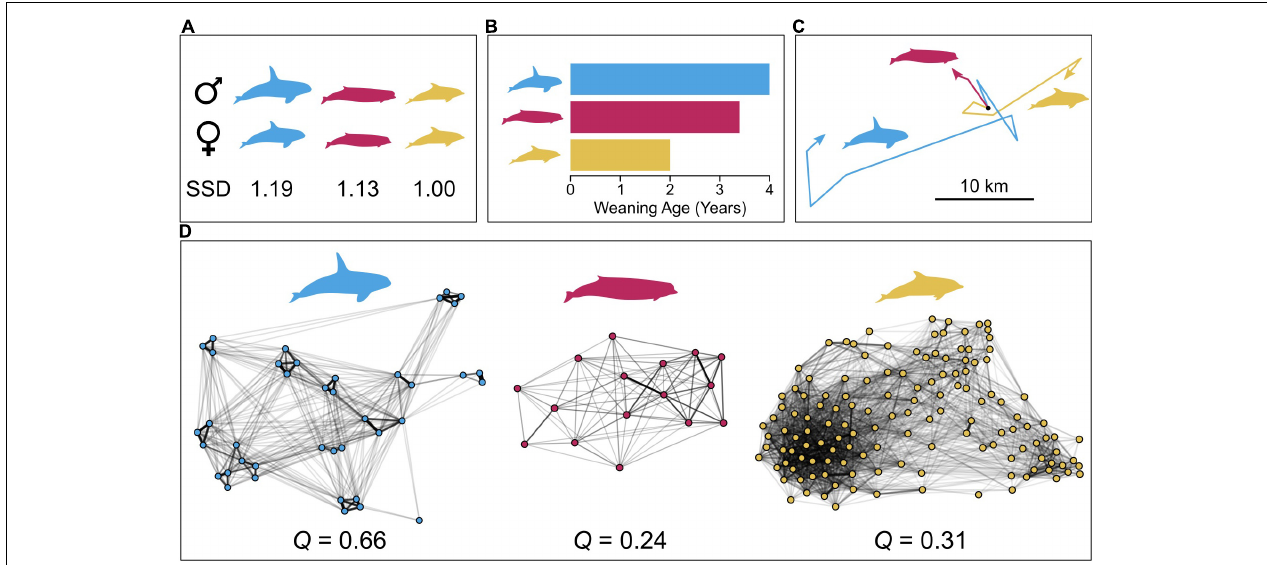
FIGURE 2 | Comparison of network structure and hypothesized drivers in three species of toothed whale, killer whales (blue), northern bottlenose whales (red), and common bottlenose dolphins (yellow). Top panels indicate sexual size dimorphism (SSD) (A) , maternal investment, approximated by weaning age (B) , and the distribution of resources, as approximated by movement patterns (C) . The bottom panel (D) contains plots of group-based half-weight index networks for each species with accompanying modularity estimate. Sexual size dimorphism estimates are the ratio of male to female lengths, and are taken from Dines et al. (2015). Weaning ages are based on stable isotope analysis of dental layers (killer whales: Newsome et al., 2009; bottlenose whales: Feyrer et al., 2020; bottlenose dolphins: Fruet et al., 2015). Movement data are tracks of single individuals obtained from animal-borne devices (radio tag for bottlenose whales, satellite tags for bottlenose dolphins and killer whales) over approximately 24 h, with a common initial point and tracks rotated for clarity. Movement and social data are taken from killer whales at the Prince Edward Islands, bottlenose whales at the Gully, Nova Scotia, and bottlenose dolphins off Georgia, United States. Movement data are replotted from Hooker et al. (2002); Reisinger et al. (2015), and Balmer et al. (2018), and social networks are replotted from Whitehead and James (2015); Reisinger et al. (2017), and Kovacs et al. (2017). Species silhouettes are by Chris Huh, re-used here with alteration under a Creative Commons Share-alike license